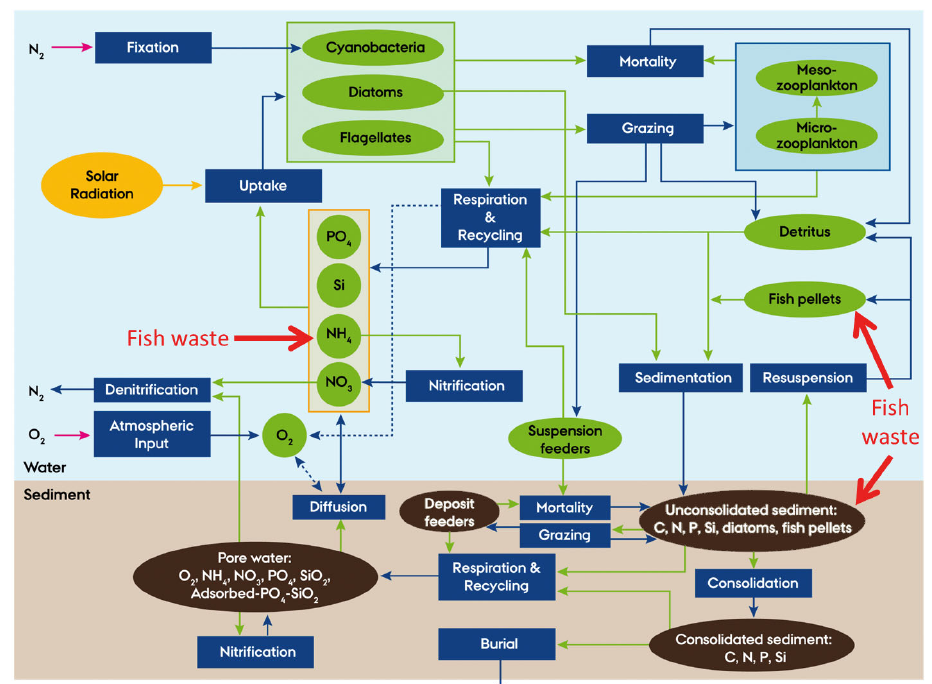
Fig. 2. ERGOM model. Blue boxes are processes, green circles and ovals are state variables in the water column; brown ovals are state variables in the sediment; red arrows show the input of nutrients and fish pellets from the fish